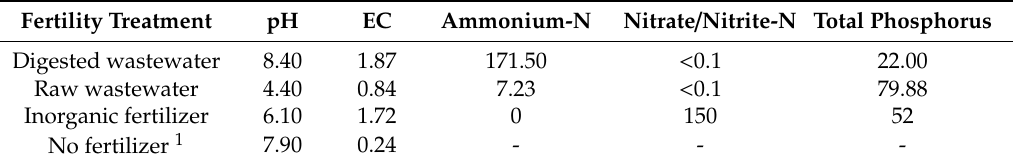
Table 3. Solution test results (pH, electrical conductivity (EC), ammonium-N, nitrate / nitrite N, total phosphorus) for each fertility treatment. Nutrient levels of digested and raw wastewater were obtained from laboratory testing while nutrient levels of inorganic fertilizer obtained from the fertilizer formulation (see Methods).